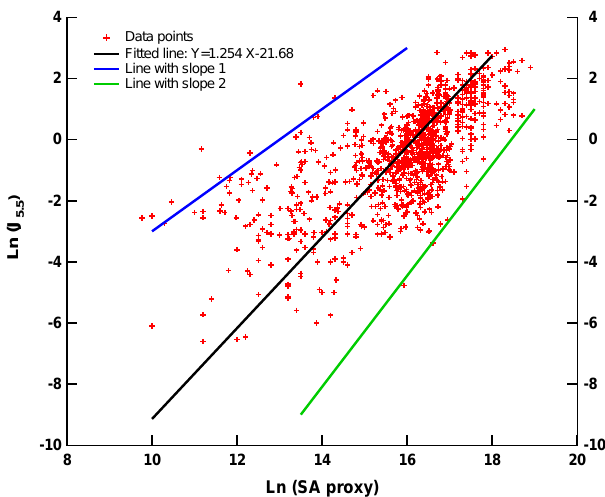
Fig. 4. The logarithm of formation rate J 5 . 5 estimated from particle Figure 4 The logarithm of formation rate J 5.5 estimated from particle measurements versus the logarithm of the sulfuric acid proxy (4 393 minutes averages) during the nucleation events from 0600~1600 LT. Sulfuric acid proxy concentrations have been delayed by the 394 measurements versus the logarithm of the sulfuric acid proxy (4min fitted time lags. Lines with slopes 1 and 2 (corresponding to values 1 and 2 in the exponent n J5.5 ) are also shown. 395 averages) during the nucleation events from 06:00–16:00LT. Sulfu- 396 ric acid proxy concentrations have been delayed by the fitted time Apart from the connection with particle nucleation, the H 2 SO 4 vapor has also been found to take part in the particle growth. 397 lags. Lines with slopes 1 and 2 (corresponding to values 1 and 2 in ) are also the exponent n J Weber et al . (1997) estimated the growth rate of nucleation mode particles from the time taken between the increase in gas phase 398 5 . 5 sulfuric acid concentration and the increase in 3 nm particle concentrations. The observed growth rates of 1–2 nm h -1 were 399